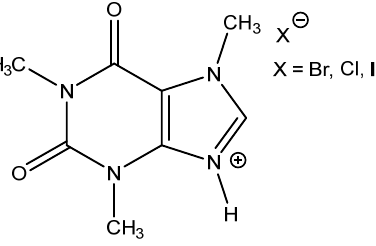
Figure 3. Structure of catalytically active caffeine hydrohalides [37].